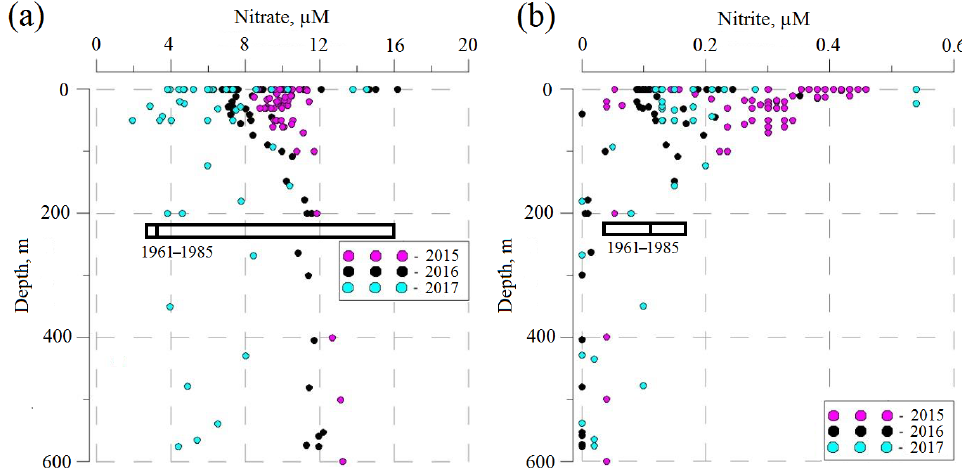
Figure 11. Vertical distributions of concentration of nitrates (a) and nitrites (b) during the surveys of 2015, 2016, and 2017. Black box indicates the typical range for waters below 200m in 1961–1985 (Kadyrov, 1986). The vertical lines in the boxes show average values.